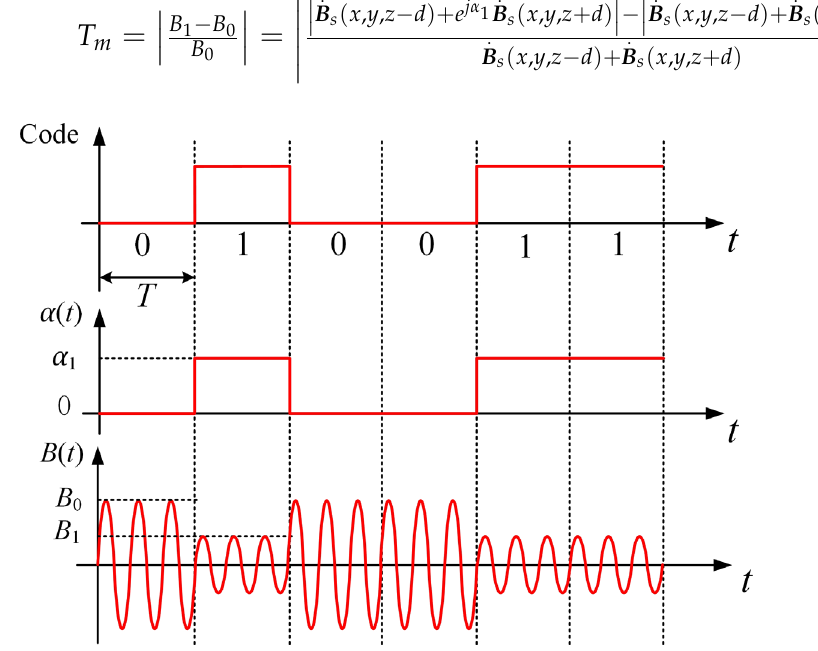
Figure 3. Waveforms of the amplitude modulation signal in an ideal case.